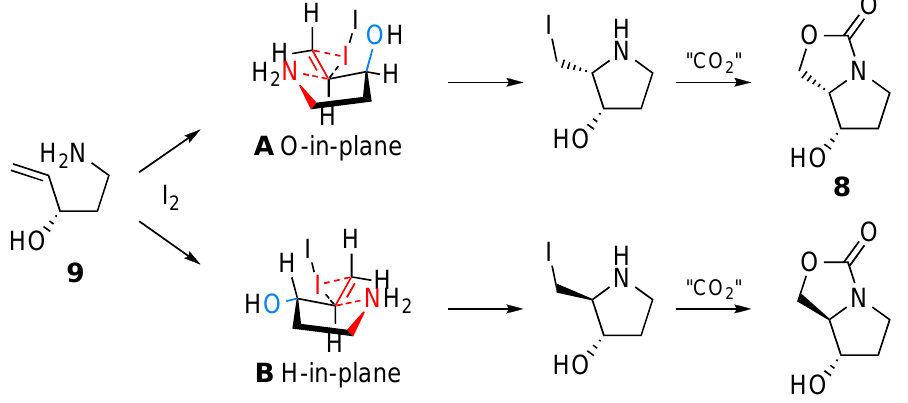
Figure 2. Proposed transition state for iodine-promoted carbamate